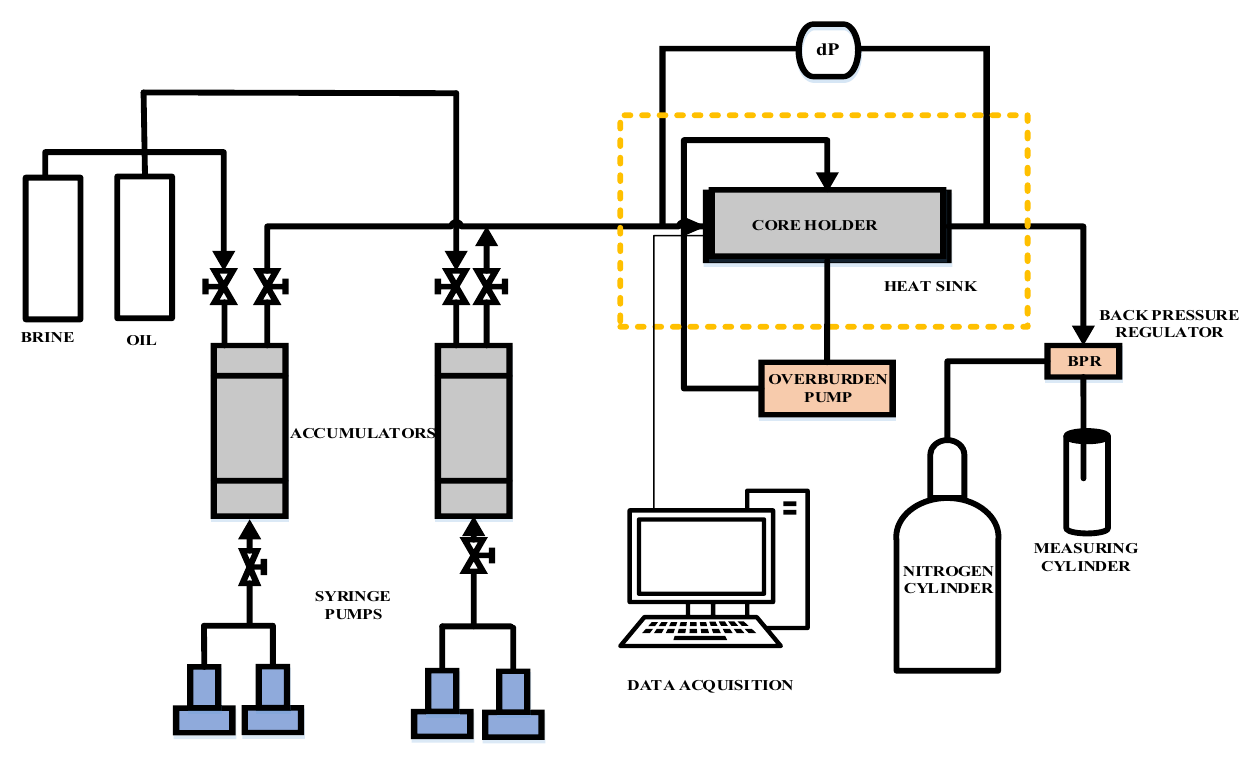
Fig. 4 Core flooding set-up schematics